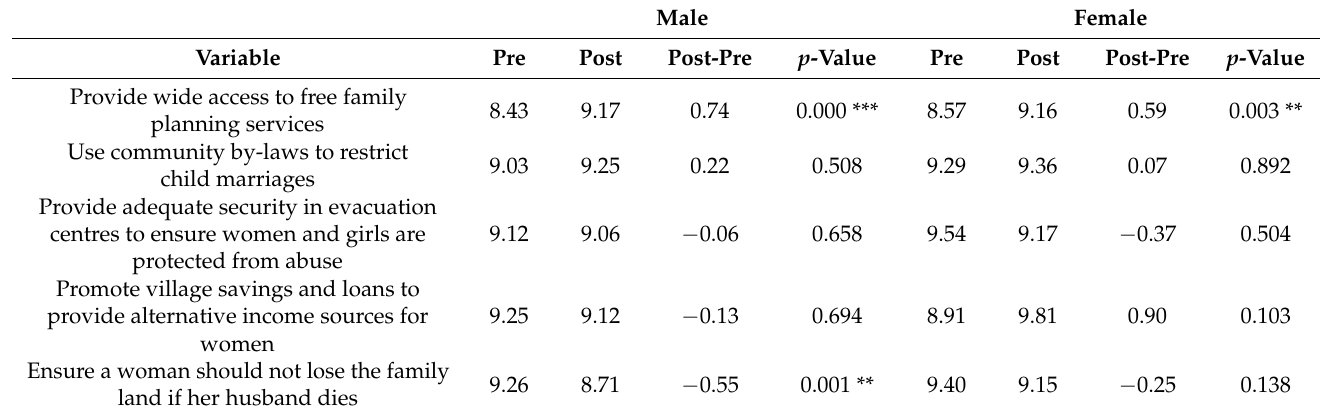
Table 5. Comparing pre- and post means of the study participants on five gender related variables by sex. Male